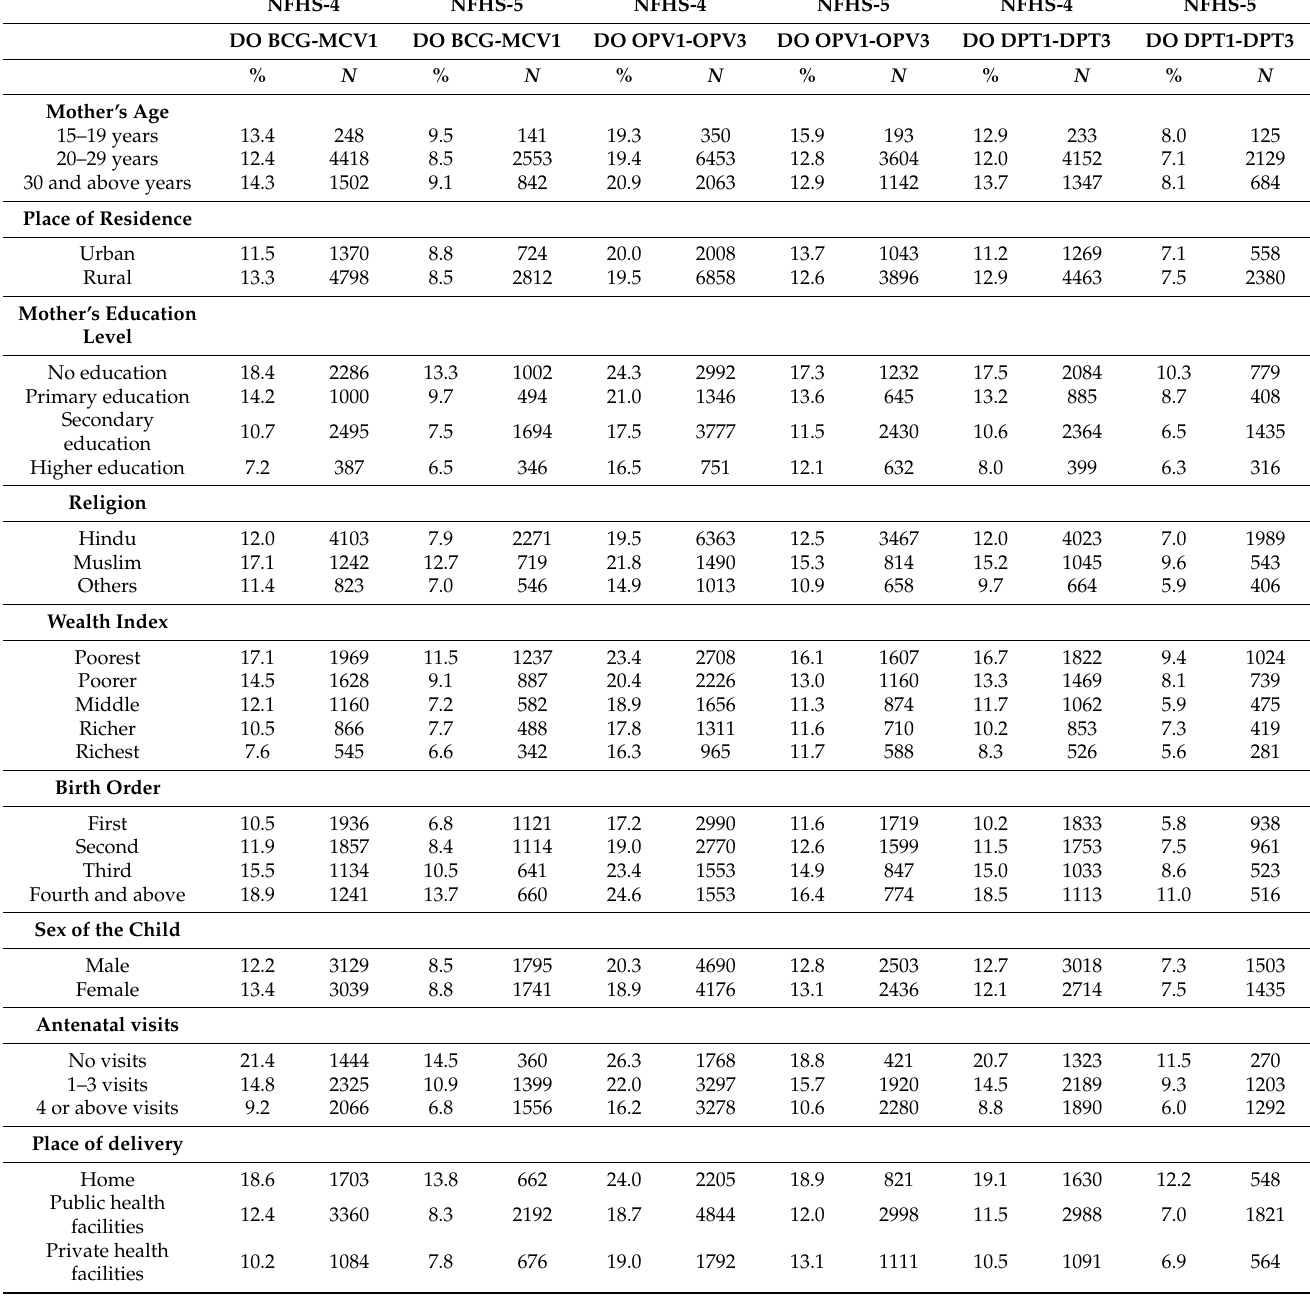
Table 3. Percentage distribution of dropout rates by background characteristics in NFHS-4 and